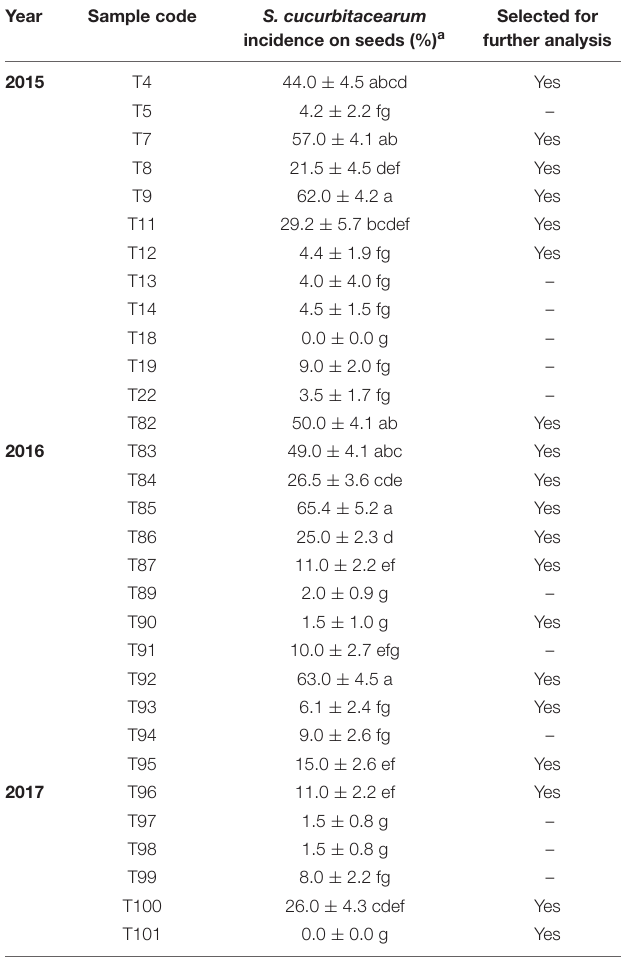
TABLE 1 | Incidence of Stagonosporopsis cucurbitacearum infection using the blotter method for the 31 squash seed samples collected in 2015, 2016, and